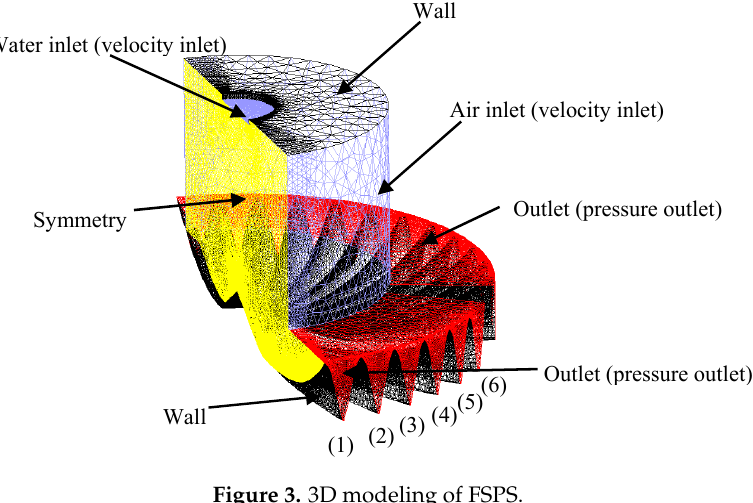
Figure 3. 3D modeling of FSPS. Table 1. Inlet velocities (m/s) of four nozzle diameters for the simulations. Working Pressure